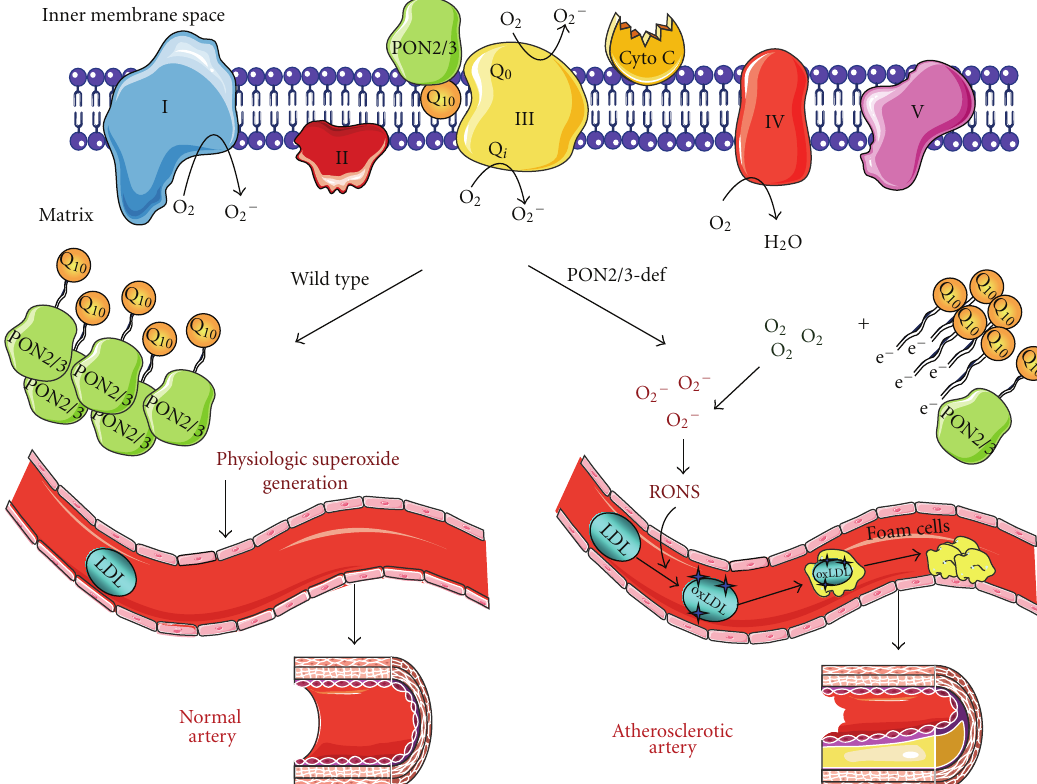
Figure 2: Schematic presentation of the suggested antioxidative mechanism of PON2 and PON3. A current model for the role of PON2/3 in the development of atherosclerosis. Ubisemiquinone is released from ETC in the mitochondria during Q cycle. Right. In the absence of PON2/3, ubisemiquinone donates electron to molecular oxygen to form superoxide; superoxide generates other reactive oxygen/nitrogen species (RONS), which oxidize LDL to form oxLDL; macrophages engulf oxLDL to form foam cells; foam cells attach to the arterial wall and subsequently develop into atherosclerotic lesions. Left. In the presence of PON2/3 (in wild type mice), ubisemiquinone binds to PON2/3. The binding of PON2/3 and ubisemiquinone prevents superoxide generation thereby preventing the development of atherosclerosis. Note: it is currently unknown if PON2/3 face the matrix side of the inner mitochondrial membrane or the one directed towards the innermembrane space; also, the stoichiometry of PON2/3 versus Q10 is unknown. Abbreviations: I-NADH: ubiquinone oxidoreductase, II: succinate coenzyme Q reductase, III: ubiquinol cytochrome coxidoreductase, IV: cytochrome c oxidase, V-ATP synthase, Cyto c cytochrome c, Q10- coenzyme